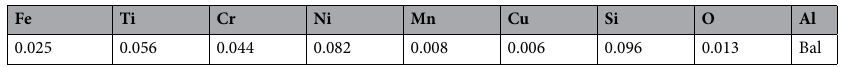
Table 2. Chemical composition of Al powder as starting